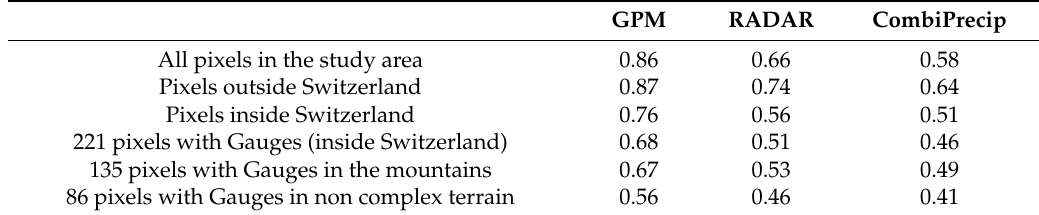
Table 6. Coefficient of Variation (st. deviation divided by the mean) of linear precipitation